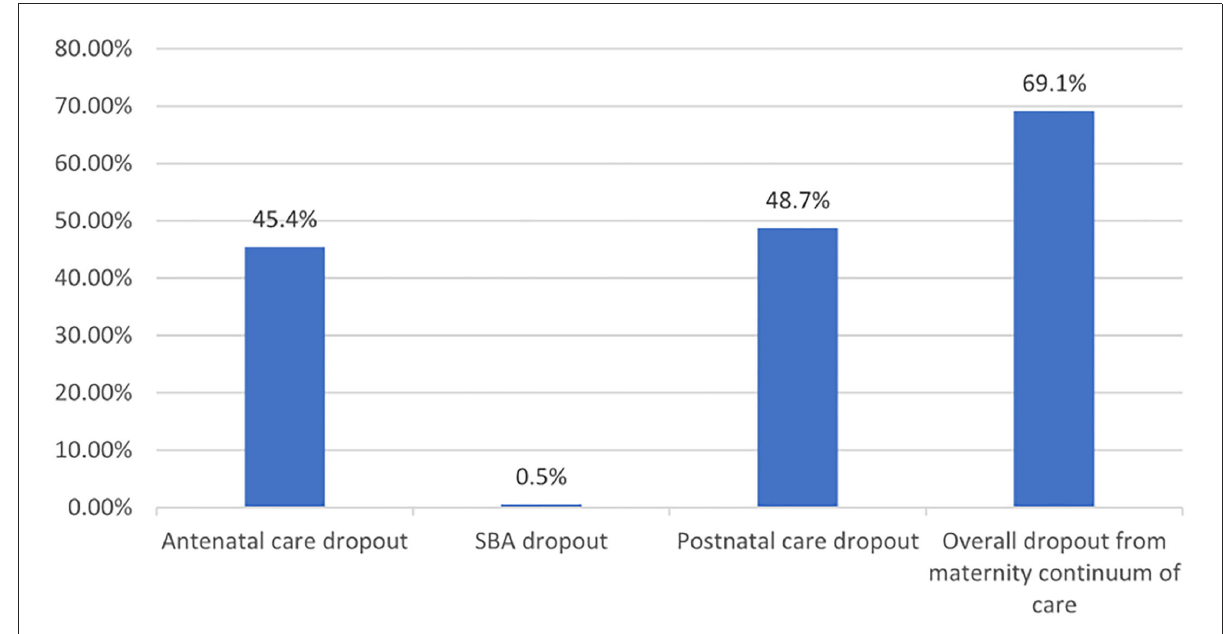
FIGURE1 Dropout from the maternal continuum of care along the continuum care pathway in Debre Berhan Town Northeast